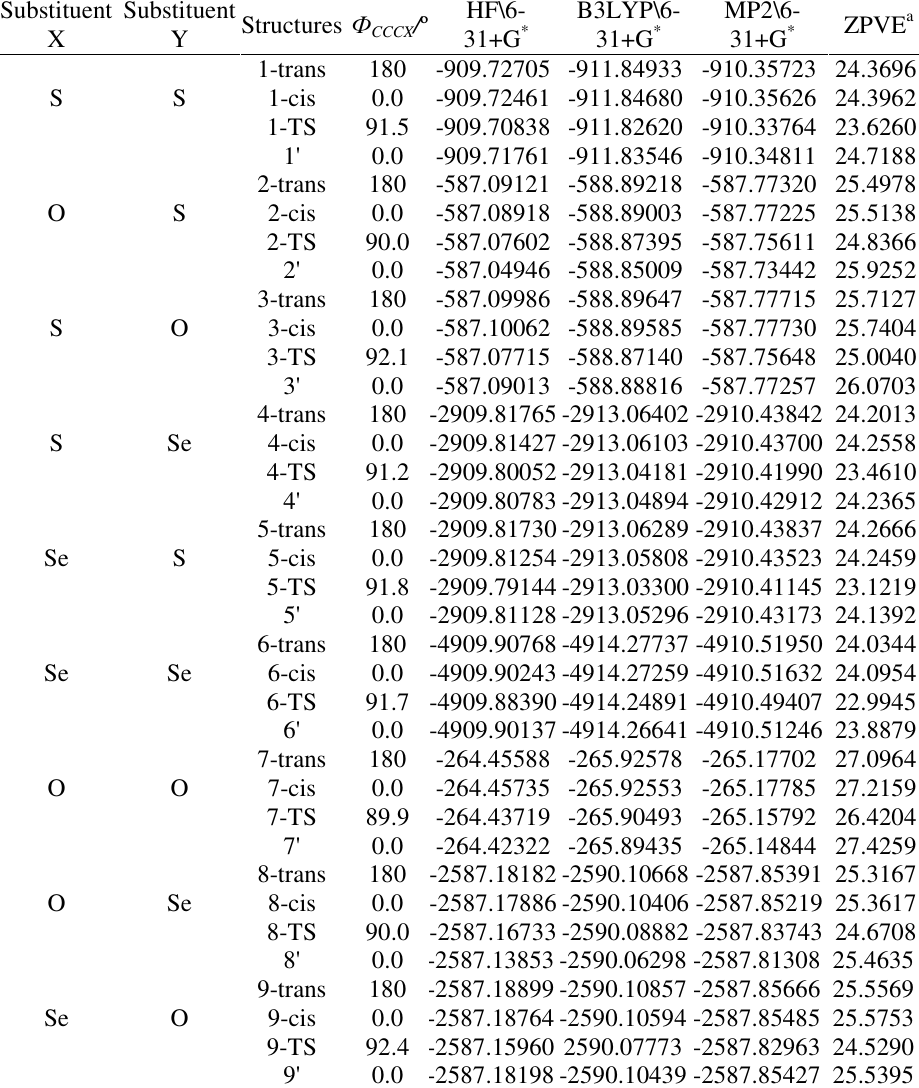
Table 1. Calculated total energies (hartree) and zero-point energy (kJ mol -1 ) for 1-9 [X=CH- H=C=Y (X and Y= O, S and Se)] and 1'-9' , including linear and their own cyclic